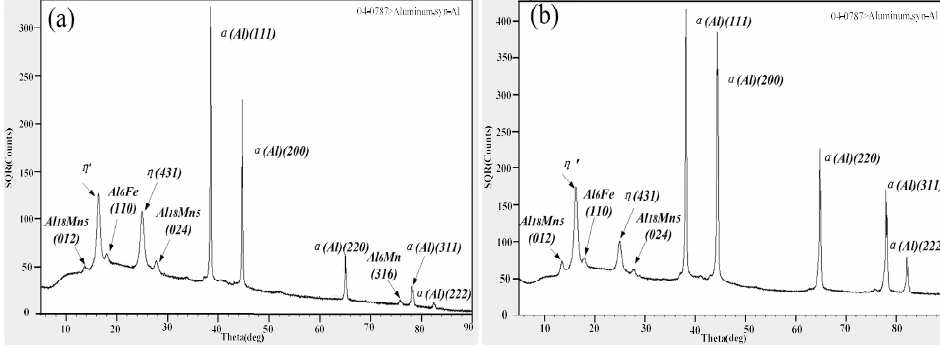
Figure 10. XRD study of the microstructure of different parts of the two alloys in the weld joint: ( a ) microstructure of the base metal (7BM); ( b ) microstructure of the heat-affected zone adjacent to the base metal (7HAZ); ( c ) microstructure of the fusion zone; ( d ) microstructure of the heat-affected zone adjacent to the base metal (5HAZ); ( e ) microstructure of the base metal (5BM). 4. Discussion